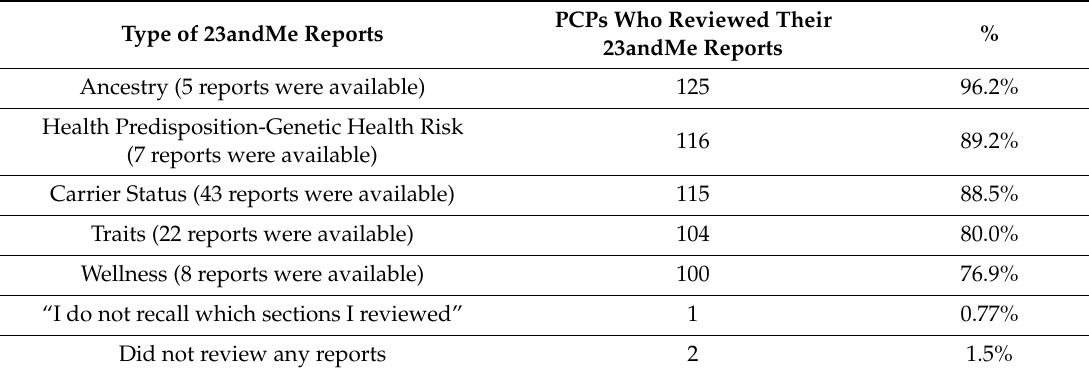
Table 6. 23andMe reports accessed by